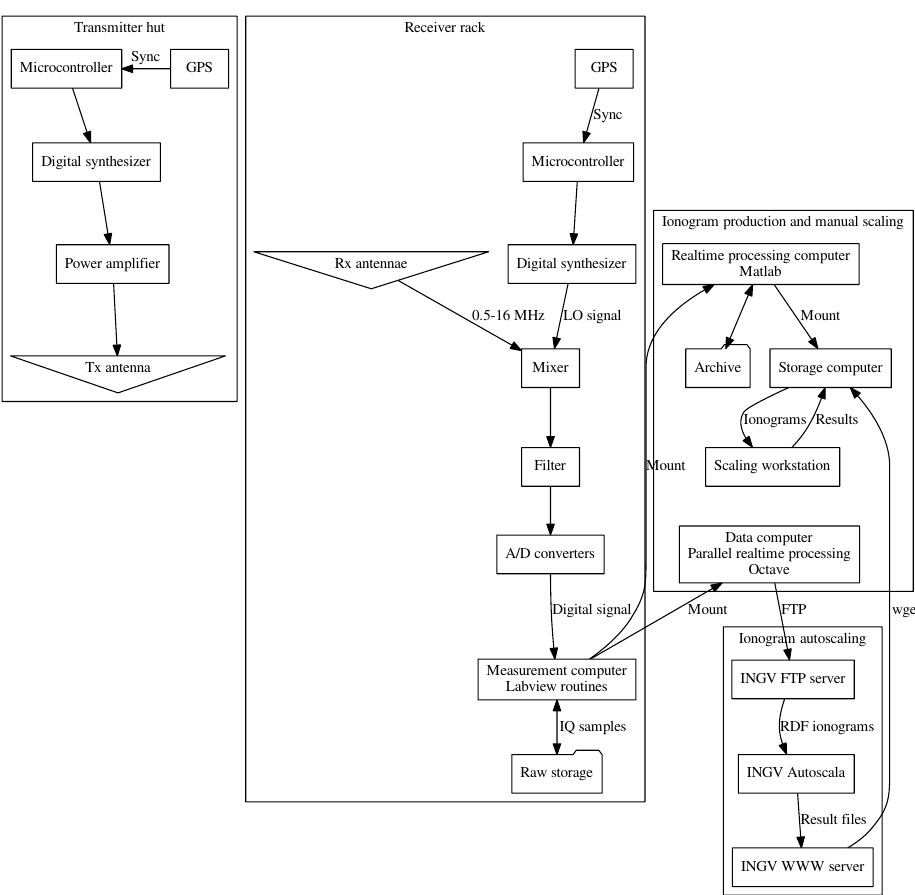
Figure 1. Simplified schematic diagram of the SGO ionosonde system and data flow. Note that the transmitter and receiver station are separated by almost 1km and have no direct electronic connection. Transmission and reception of the FM CW chirps both start by GPS synchronisation. Left column: schematics of transmitter station with exciter (direct digital synthesizer) and power amplifier. Filters are not shown. The transmitter feeds a wide-band rhombic antenna. Centre column: schematics of one receiver channel. Signals from all receiver antennas are combined into two channels, one per polarisation. The local oscillator is identical to the exciter. Raw data are saved in binary files containing four real (or two complex) vectors: two linear polarisations, samples of in-phase and quadrature-mixed filtered signals. Right upper: the real-time processing computer reads the raw data, combines the polarisations into O-mode circular polarisation (applying phase corrections), and produces ionograms. O-mode ionograms are stored and those from each full hour are interpreted manually. Right lower: during the described test phase, O- and X-mode ionograms were uploaded to INGV in the raw data format (RDF) required by